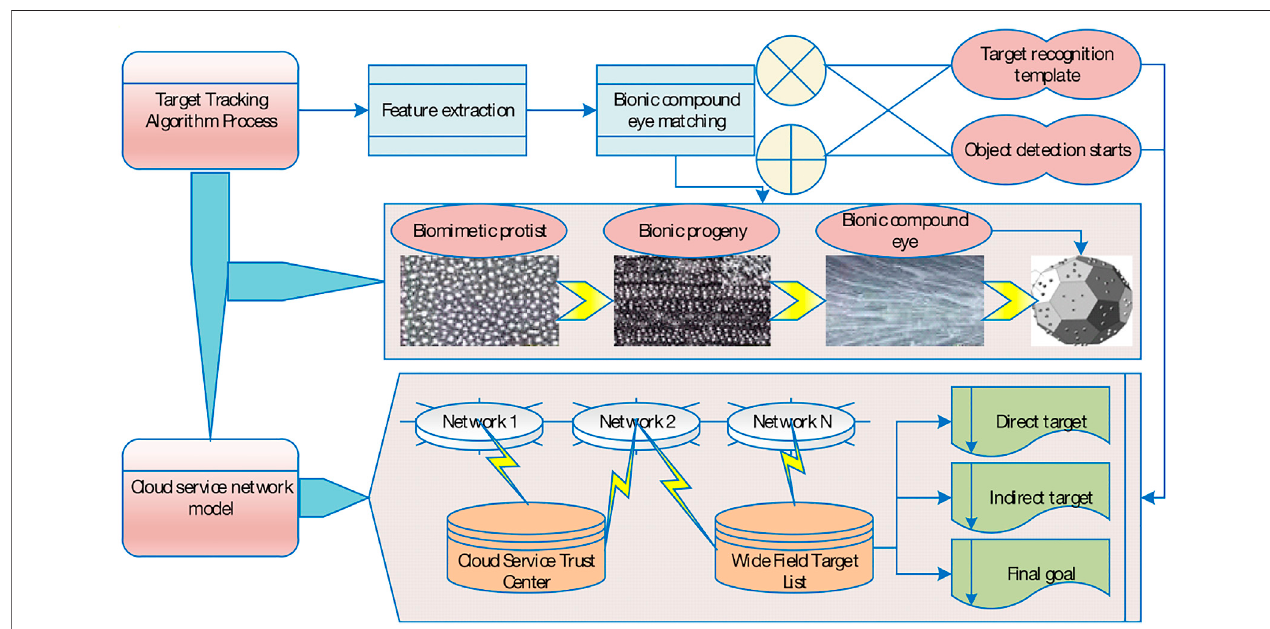
FIGURE 1 | General fl ow chart of the tracking